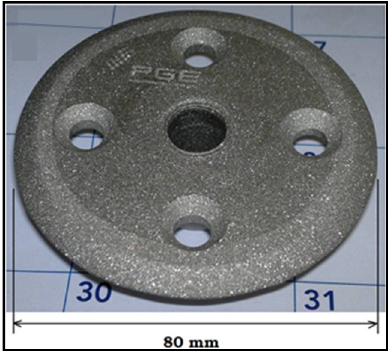
Figure 3. Both small and large components are produced using PIM. The marine hold-down produced from titanium for Earthrace Conservation for the Earthrace 2 vessel, is >300 g [Image by permission AME Powder Technology Ltd. Hamilton New